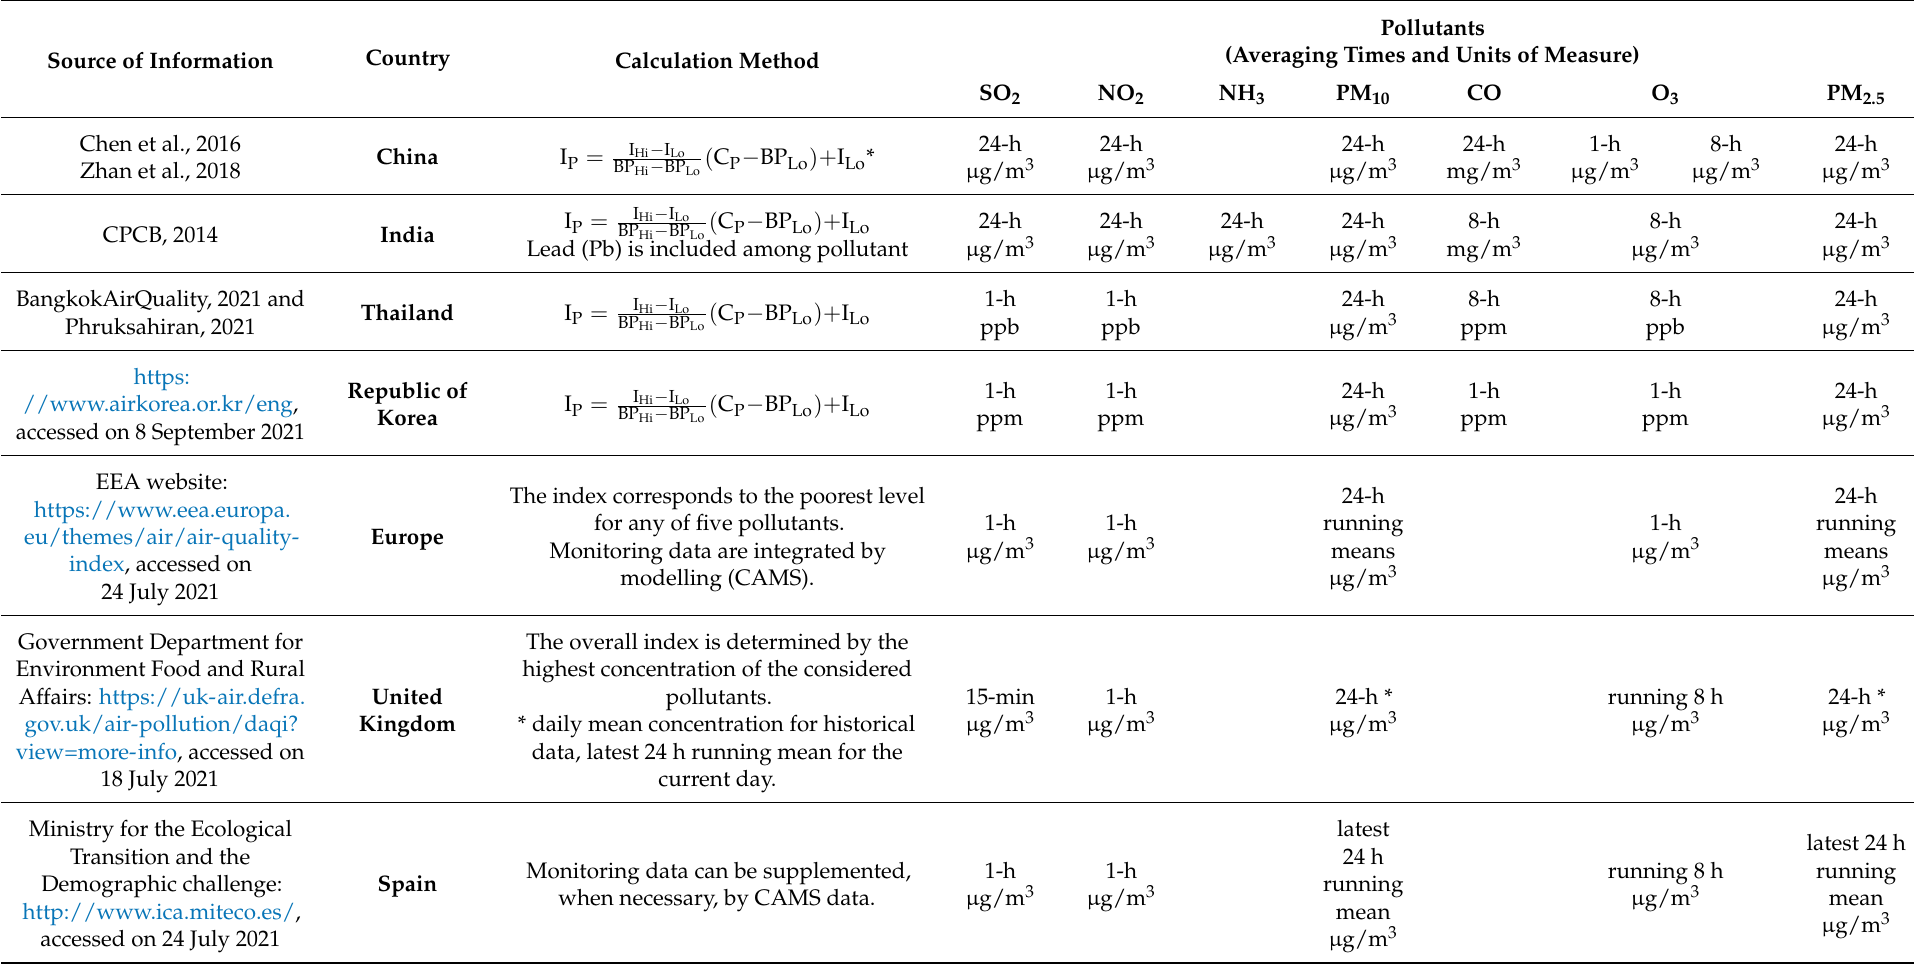
Table 1. Air quality indexes calculating expressions and relative parameters.